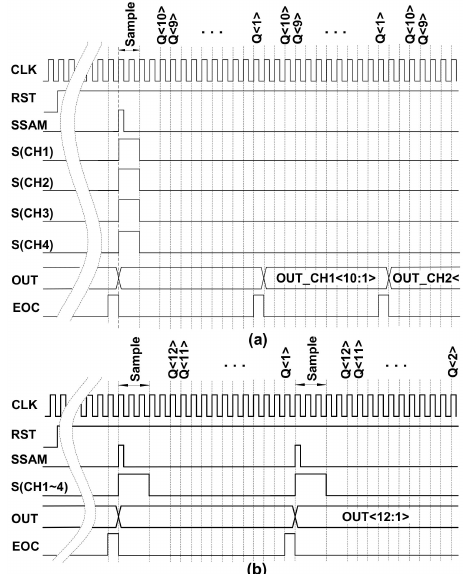
Figure 6. Timing diagram for ( a ) 10-bit operating mode with simultaneous sampling and bit decision; ( b ) 12-bit operating